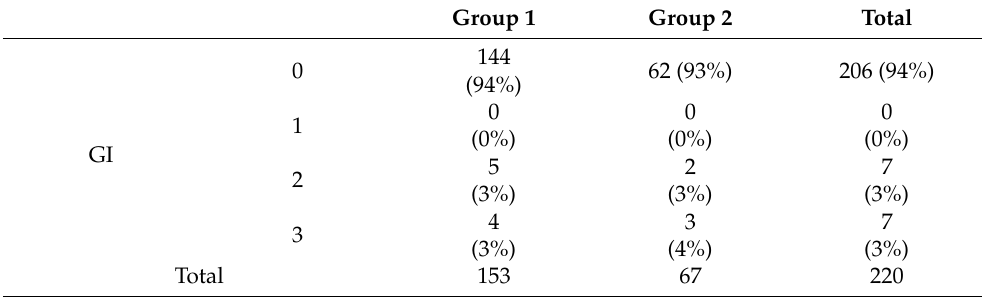
Table 9. Gingival index in Group 1 (EA ≥ 30 ◦ ) and Group 2 (EA < 30 ◦ ).